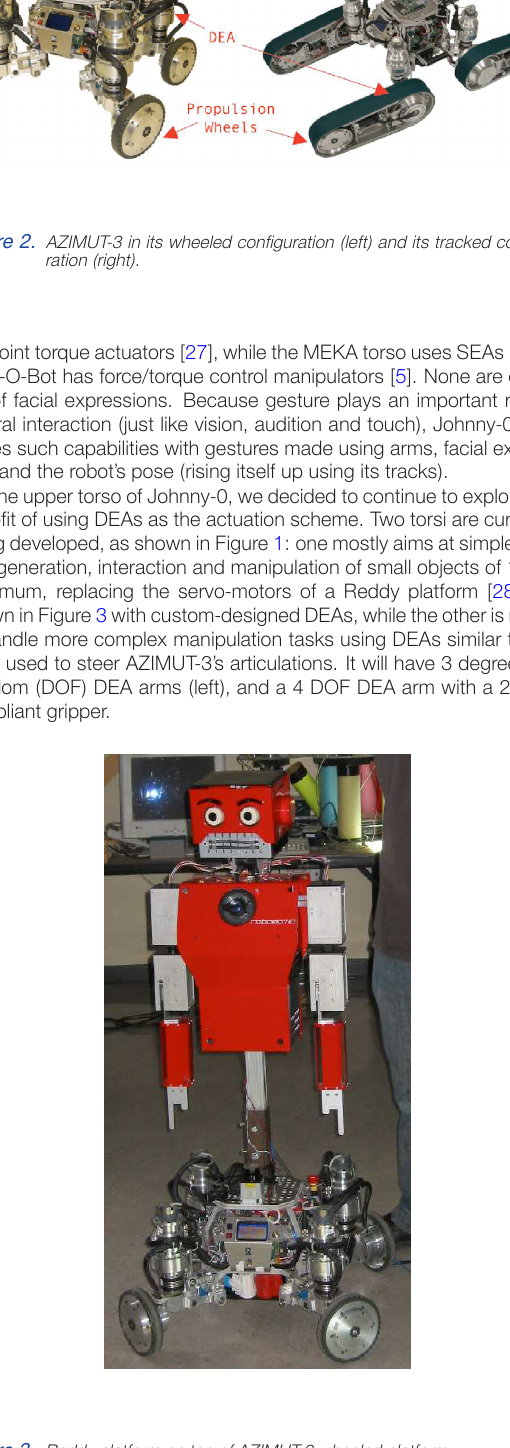
Figure 3. Reddy platform on top of AZIMUT-3 wheeled